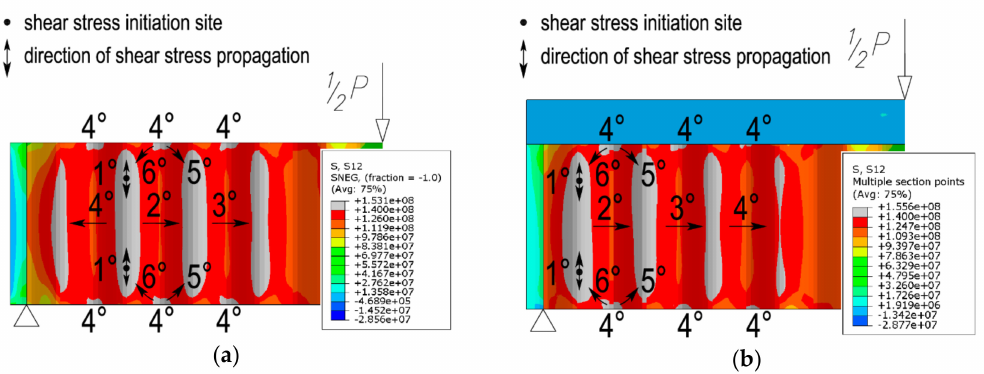
Figure 12. Mode of propagation of shear stresses with increasing load in the sinusoidal web (unit: Pa): ( a ) steel beam; ( b ) beam bonded to a reinforced concrete